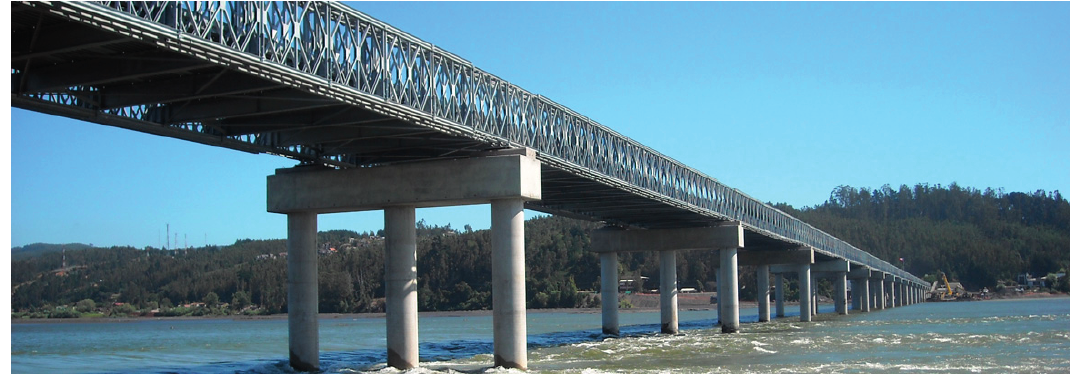
Figure 2. Emergency bridge over Bio Bio River in Concepci ό n,